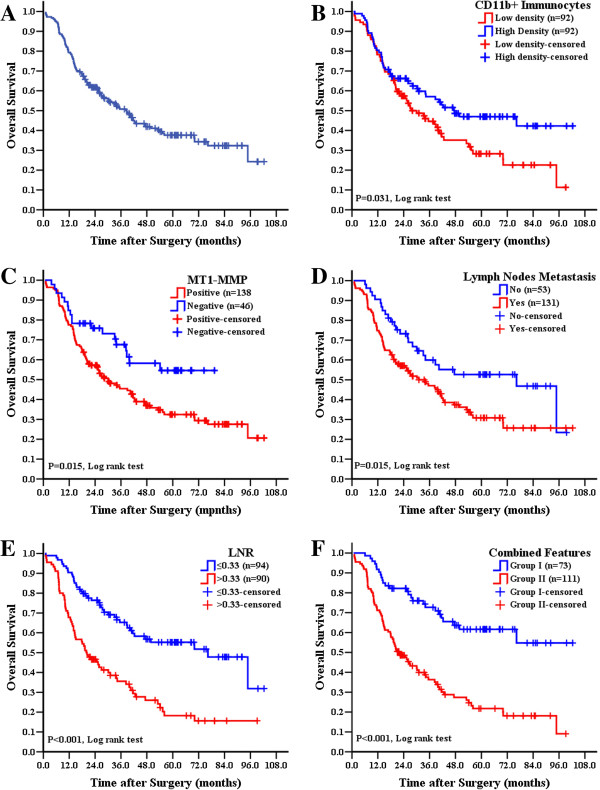
Cumulative OS of GC patients. (A) OS of 184 GC patients. (B) Low CD11b + immunocytes density was related to poor OS. (C) Patients in MT1-MMP positive group were at higher risk for death. (D, E) Both lymph nodes status and LNR were correlated with poor OS, but LNR could better differentiate patient subgroups. (F) Combined Features could indicate OS of GC patients more accurately.